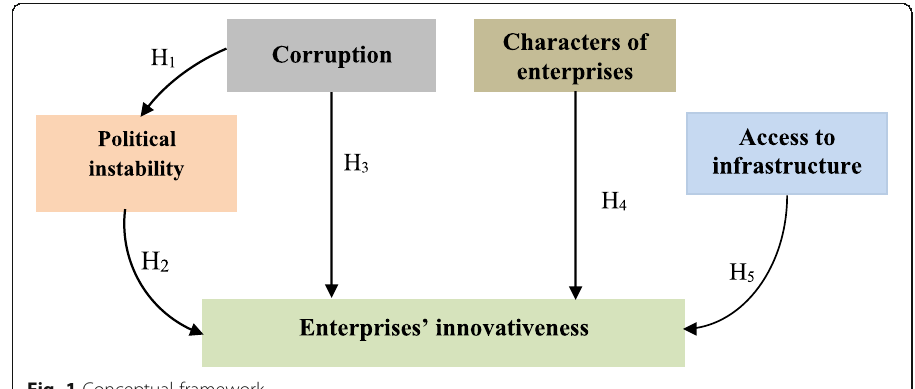
Fig. 1 Conceptual